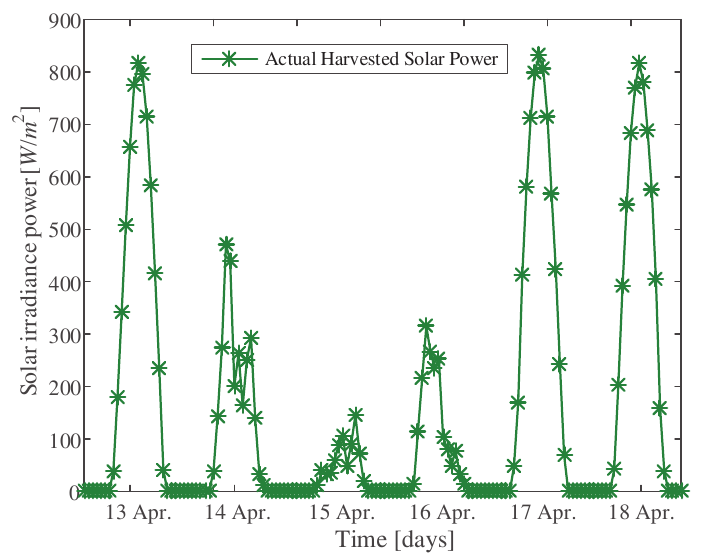
Figure 2. Solar irradiance power from 13 to 18 April